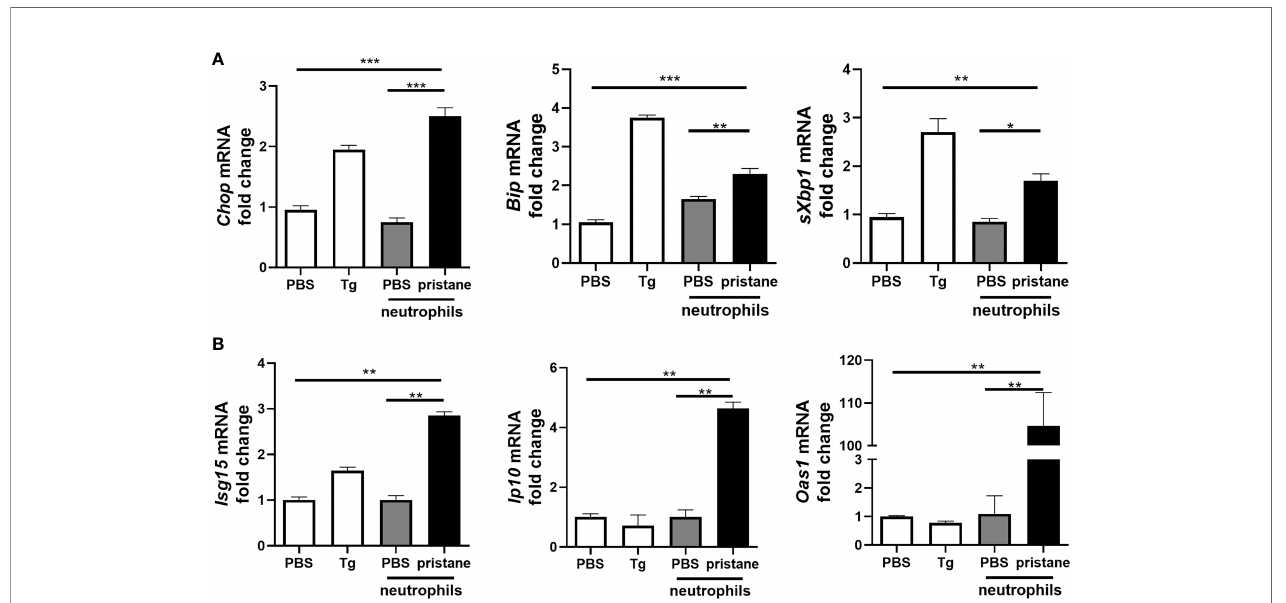
FIGURE 2 | Neutrophils from pristane-treated mice induce higher expression of ER stress and ISGs in co-culture with precision cut lung slices (PCLS). PCLS from untreated mice were cultured (1 slice/well) and stimulated with thapsigargin (Tg) as an ER stress positive control or cocultured with peritoneal neutrophils (1x10 6 /well) from PBS- or pristane-treated mice. Expression of (A) ER stress markers and (B) ISGs were determined from total cells by qPCR. Values are the mean ± SD. and are representative 3 independent experiments. Statistical signi fi cance was determined by one-way ANOVA test. * p < 0.05, ** p < 0.01 and *** p ≤ 0.001.